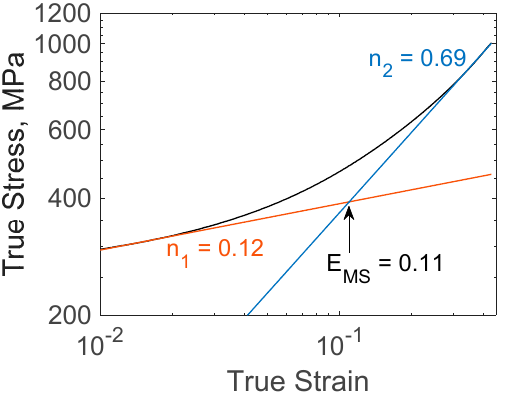
Figure 6. True stress–true stain curve in double-log plot (black curve). Fitting curves using σ = K 1 E n 1 and σ = K 2 E n2 are shown as the orange and blue curves, respectively. The fitted regions were 0.012 ≤ E ≤ 0.018 and 0.030 ≤ E ≤ 0.430, for the n 1 and n 2 curves, respectively.